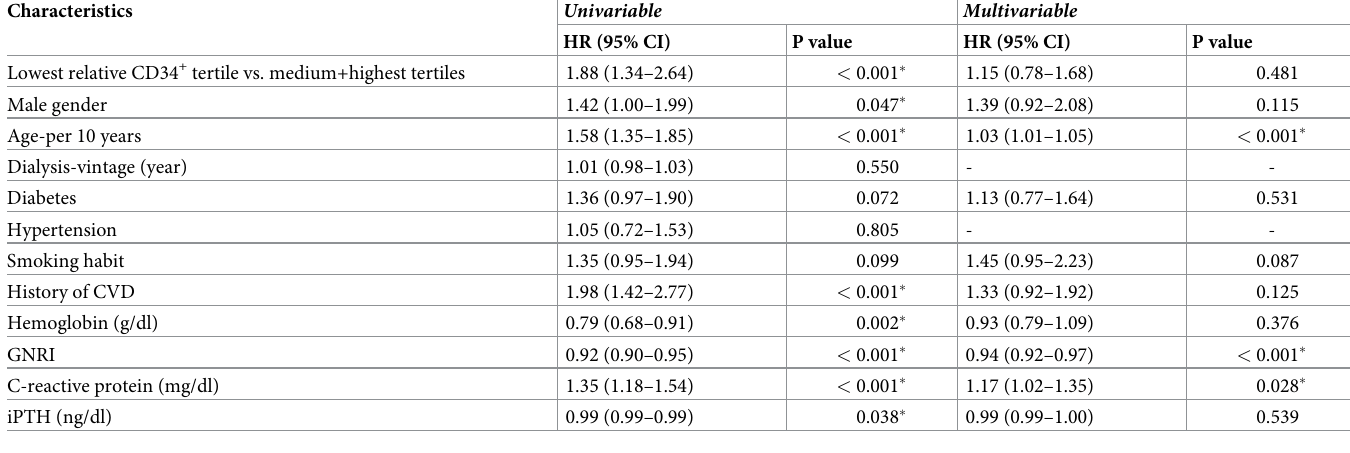
Table 4. Hazard ratio of associated factors for all-cause mortality.